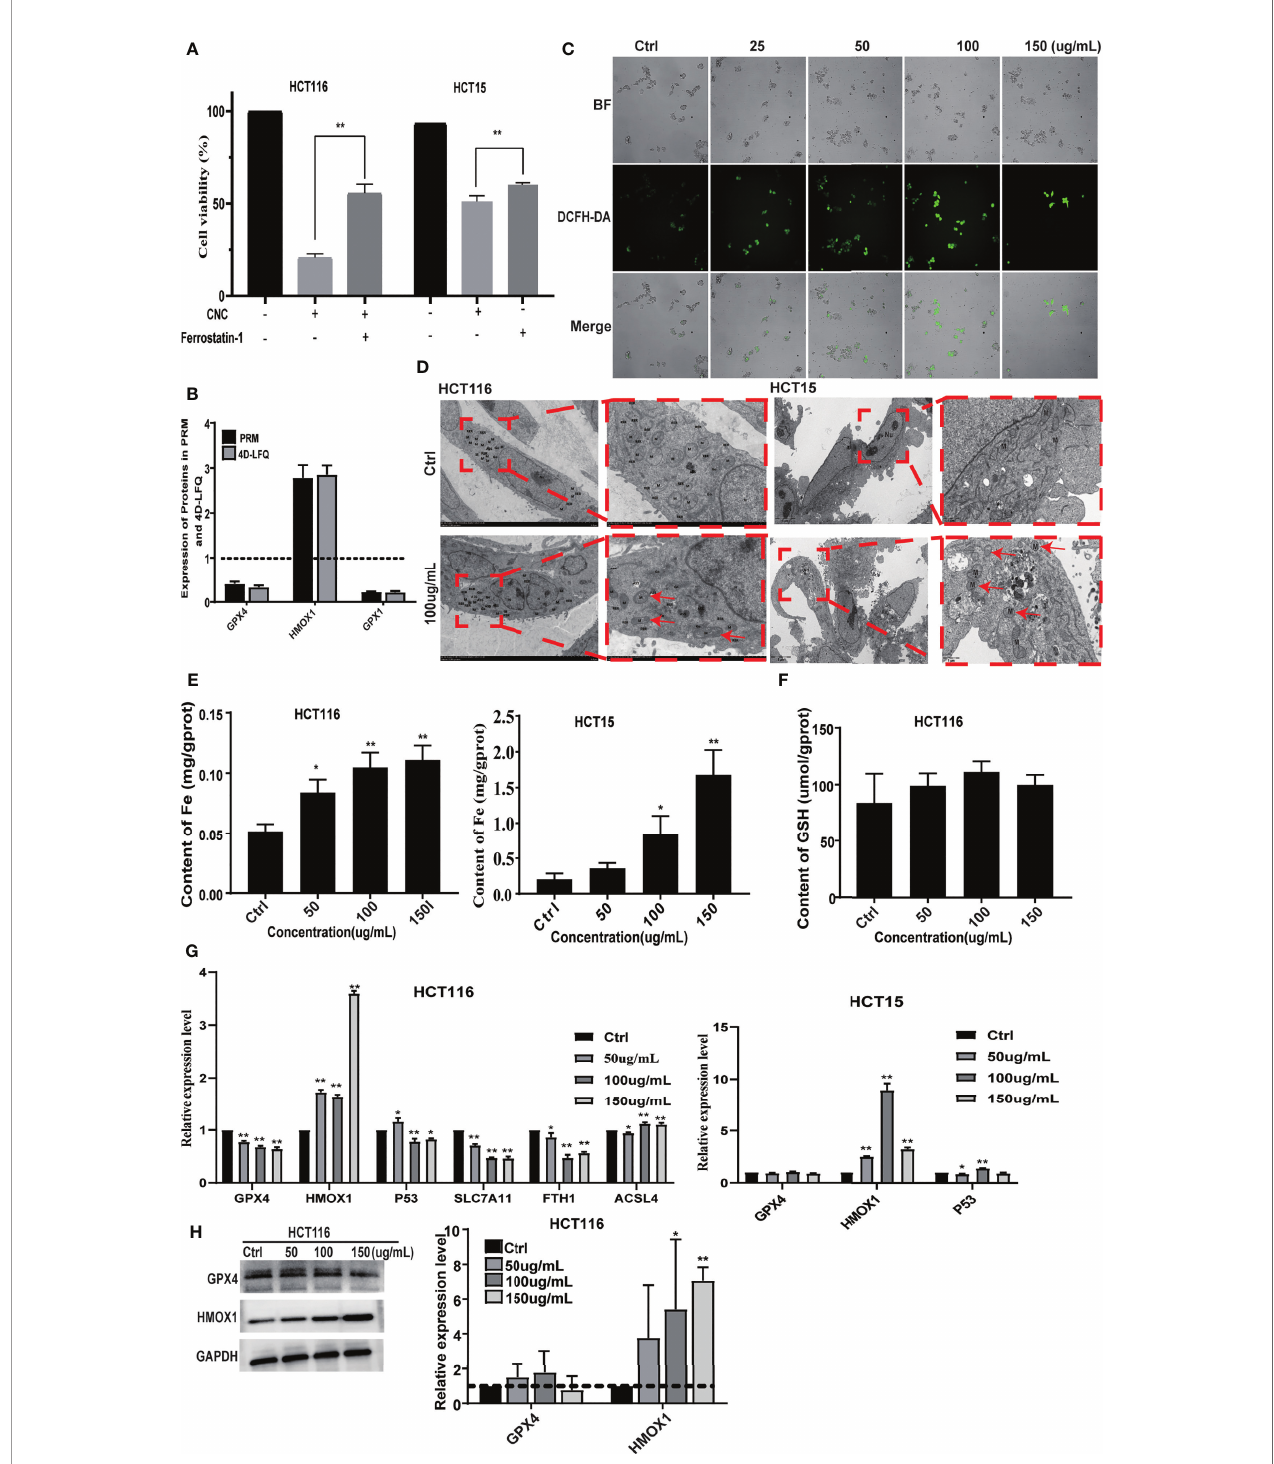
FIGURE 5 | CNC extract induce cell death by promoting ferroptosis. (A) The ferrostatin-1 rescue experiment. (B) Ferroptosis-associated proteins quanti fi cation by mass spectrometry-based targeted proteomics (PRM). (C) The detection of HCT116 cellular ROS accumulation. (D) The TEM analysis of HCT116 and HCT15 cells morphology. (E, F) The detection of cellular Fe and GSH content. (F) Expression of relevant proteins at mRNA level were detected by q-PCR. (G) Expression of GPX4 and HMOX1 in HCT116 cells was measured by western blot. There were three duplicate samples in each experiment. Data are expressed as mean ± SD. Compared with control group: *p < 0.5, **p <